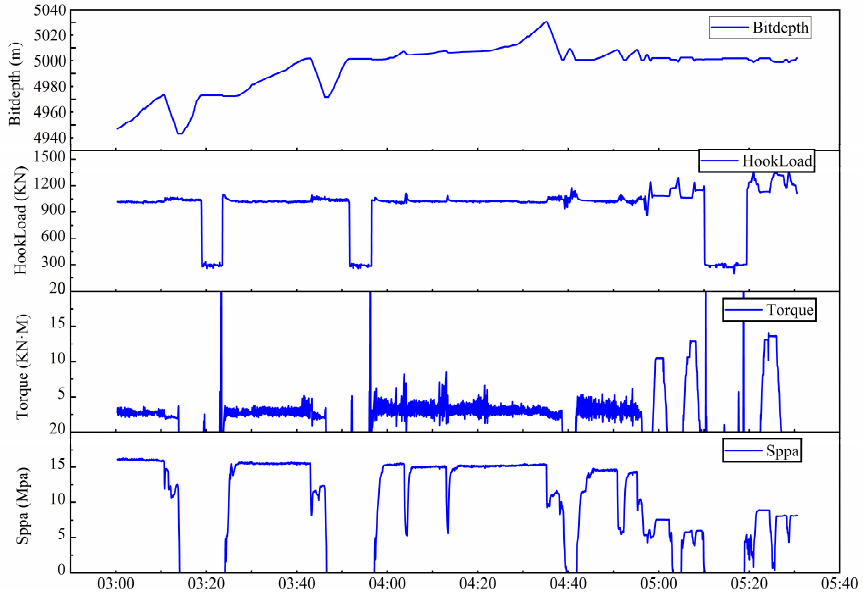
Figure 9. Stuck well logging data for well N.